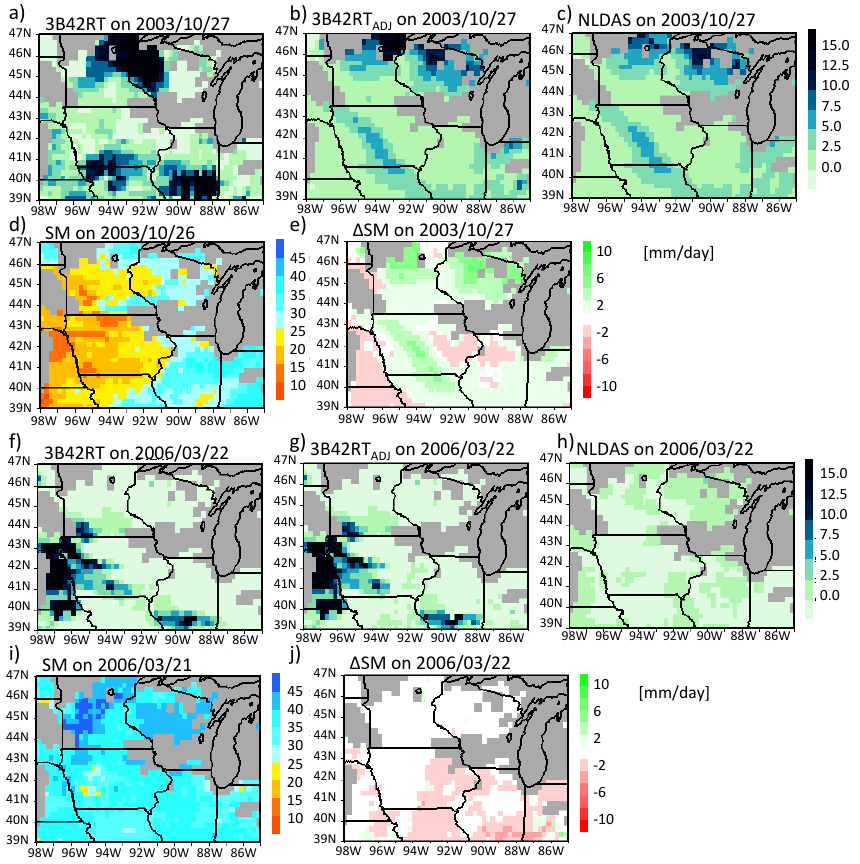
Figure 5. Two cases with recovered spatial rainfall pattern in the idealized experiment after merging satellite soil moisture retrieval